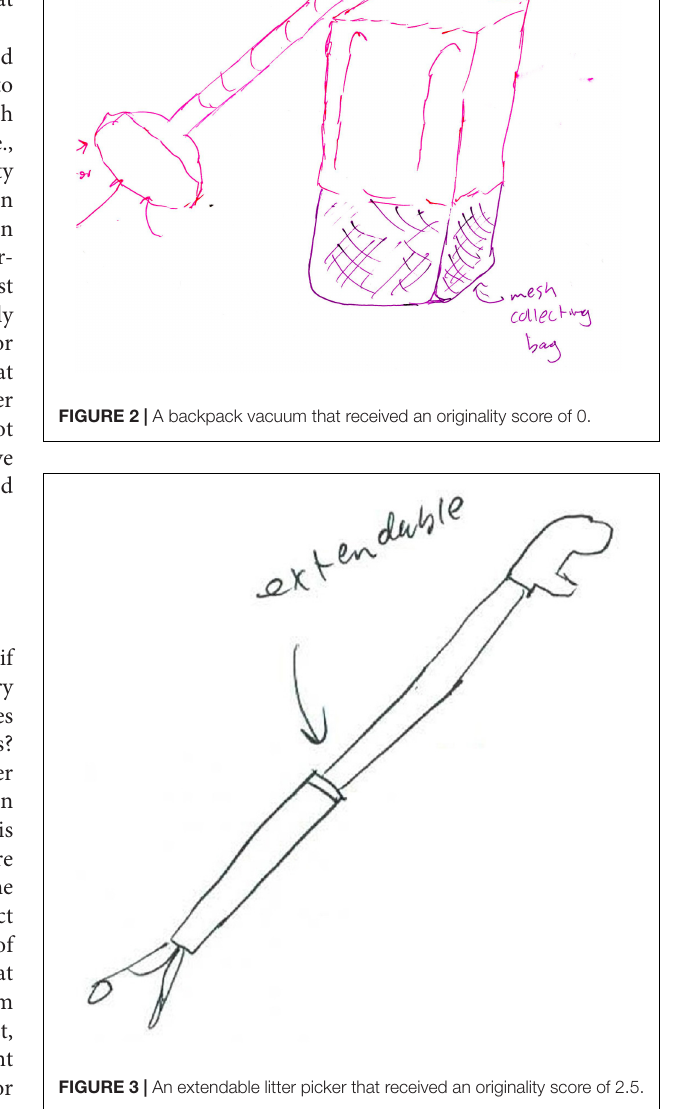
FIGURE 3 | An extendable litter picker that received an originality score of